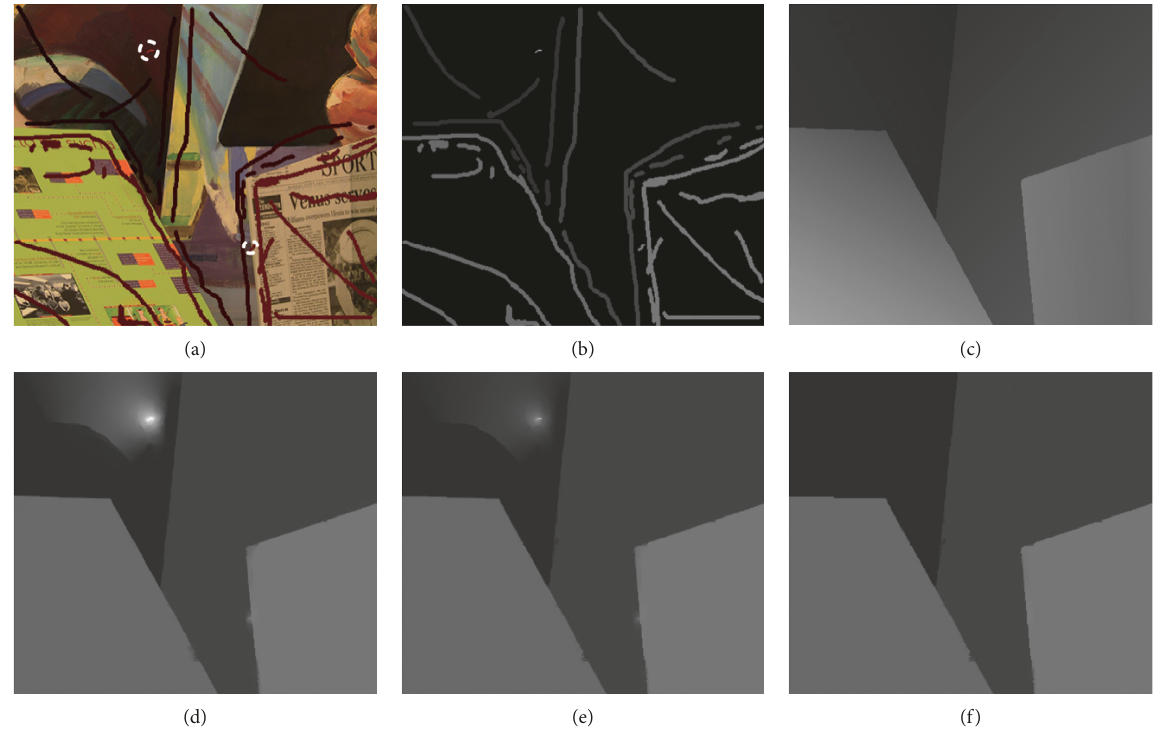
Figure 1: A sparse-to-dense depth propagation result with inaccurate input. (a) User scribbles (inaccurate scribbles are marked by the white circles). (b) Sparse depth-map extracted from user scribbles. (c) Groundtruth depth-map. (d) Depth-map generated by random walks [4]. (e) Depth-map generated by optimization method [6]. (f) Depth-map generated by the proposed method.